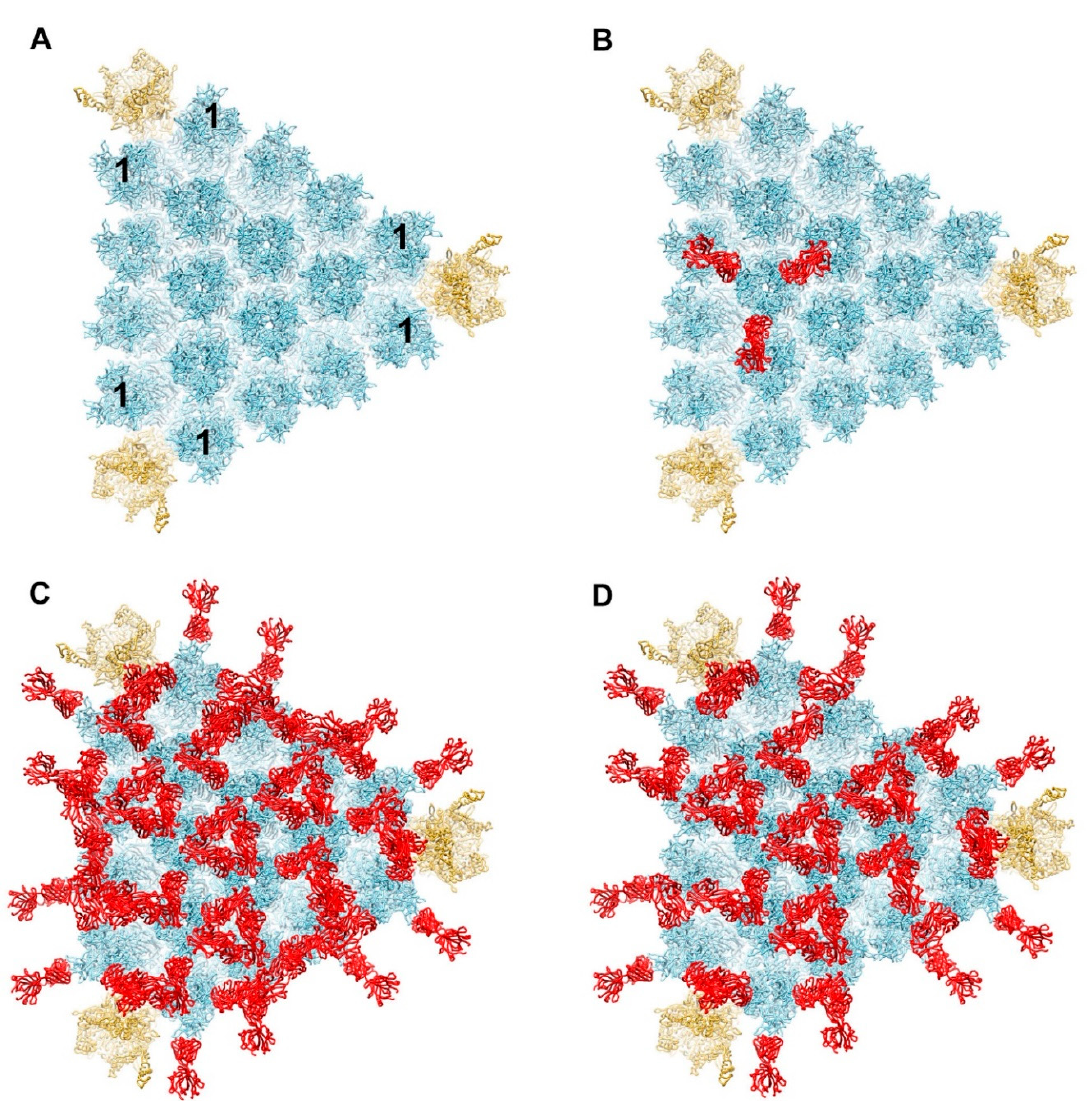
Figure 1. Model for binding of antihexon monoclonal antibody 9C12 to a facet of HAdV-C5. ( A ) Major capsid proteins in one facet of HAdV-C5 with hexons forming an array in the middle (light blue) and penton bases at the vertices (gold) (PDB: 6B1T) [36]. The peripentonal hexons are denoted with the number 1. Each penton base is shown with Rosetta-based models for the RGD loops [29]. ( B ) One hexon trimer shown with three 9C12 Fab fragments (red) positioned as in the crystal structure of isolated hexon with 9C12 Fab (PDB: 5LDN) [32]. ( C ) Fully occupied model of HAdV-C5 facet with all hexon epitopes occupied with a 9C12 Fab. ( D ) Partially occupied model with two thirds of the possible hexon epitopes occupied with a 9C12 Fab. The occupied Fab binding sites were selected so that the model would resemble the cryo-EM structure of HAdV-C5 with 9C12 IgG [33].